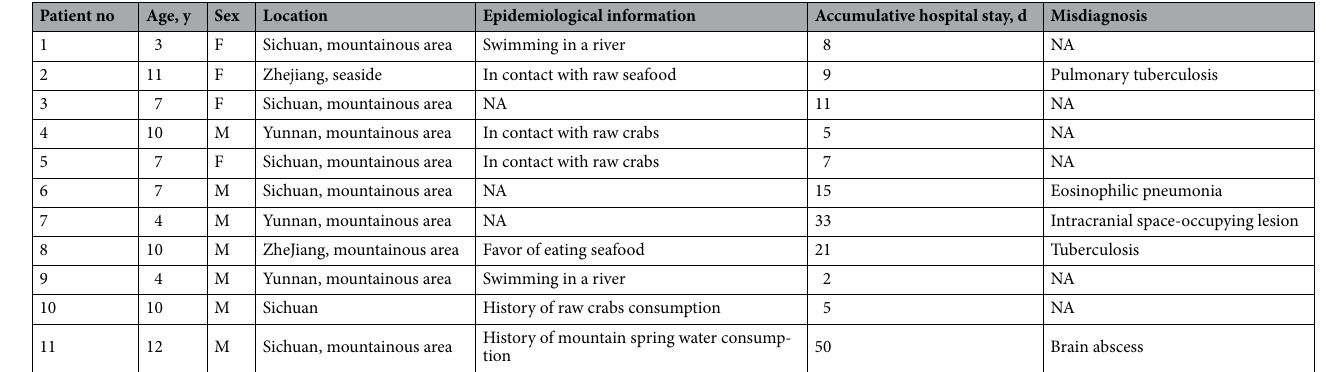
Table 1. Characteristics of 11 patients infected with Paragonimus, China, January 2011–May